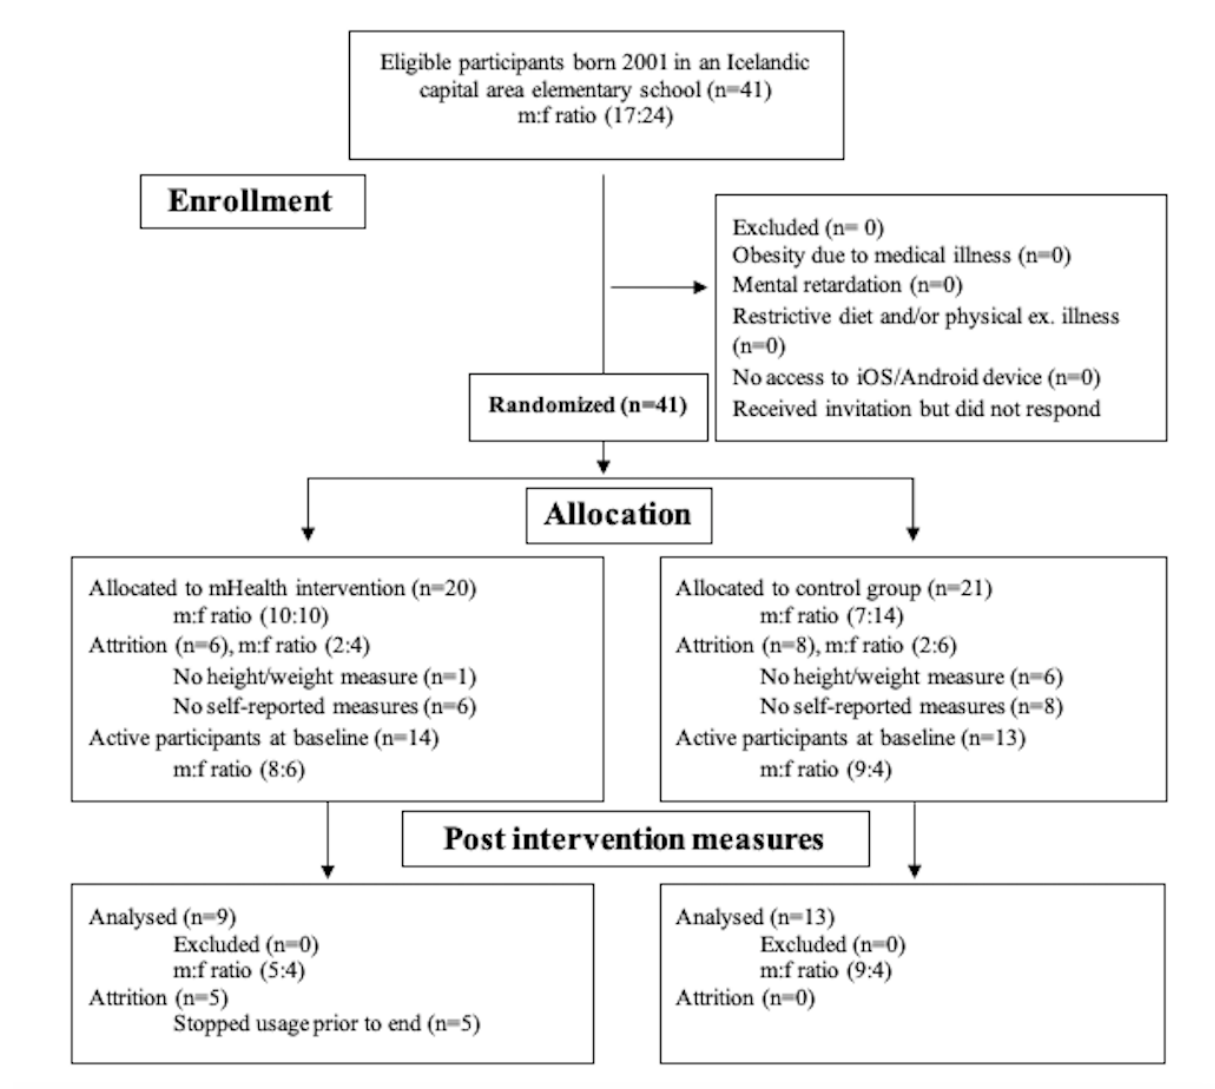
Figure 1. Pilot intervention flow chart. mHealth: mobile health; m: male; f: